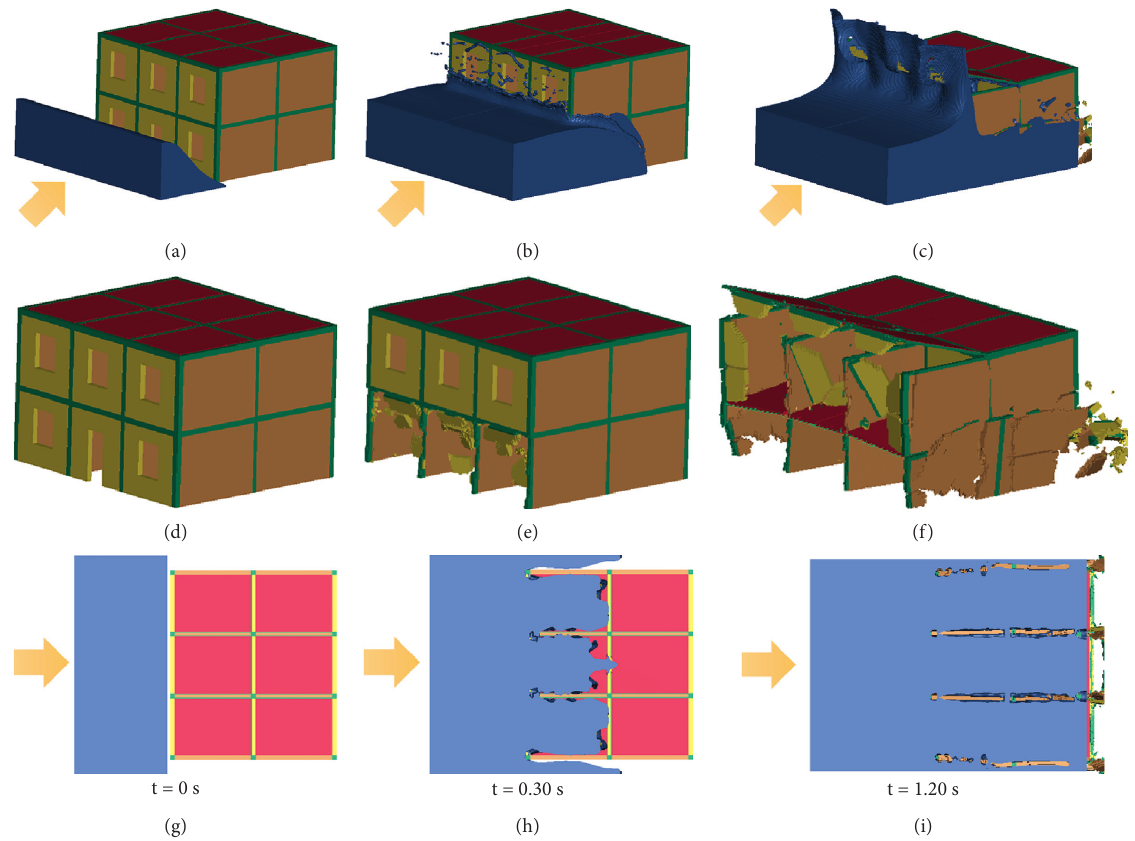
Figure 8: Snapshots in the scenario of s � 0, h � 3.2m, and v � 12.0m/s: (a–f) oblique view, and (g–i) bottom